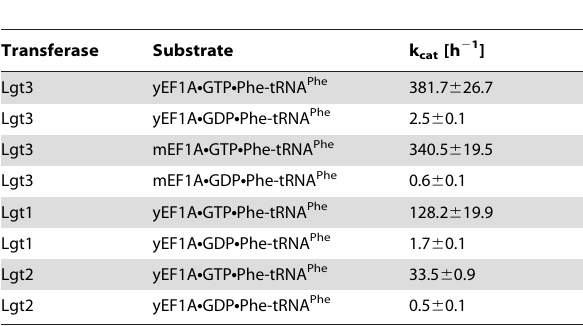
Table 1. k cat -values for glucosylation of eEF1A ternary complex by